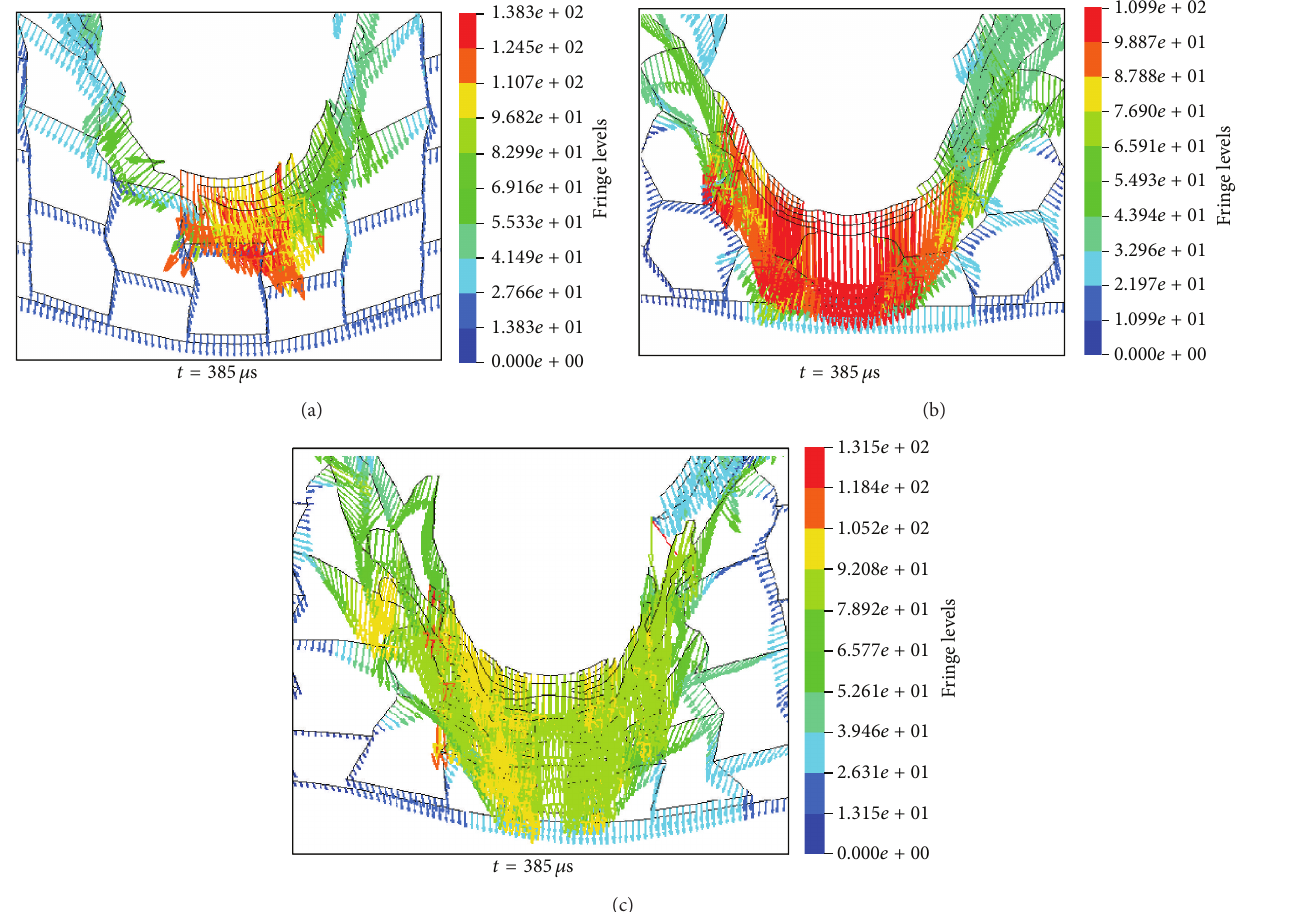
Figure 8: Local instant node velocity (amplitude and direction are represented by length and direction of the arrow, resp.) distribution of (a) R-type, (b) H-type, and (c) A-type honeycomb cores under the projectile impact at 𝑉 𝑖 = 170 m/s (projectile masked for better view).